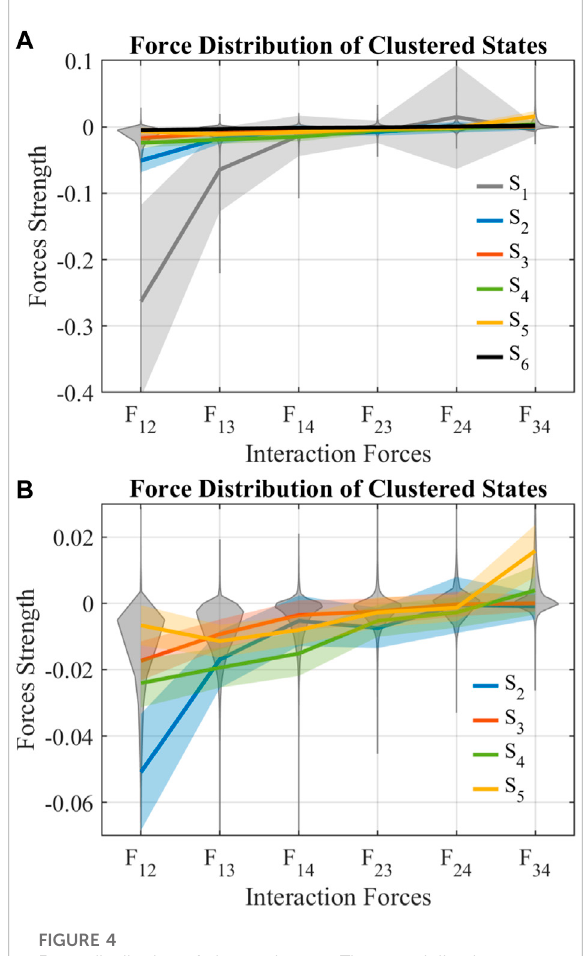
FIGURE 4 Force distribution of clustered states. The gray violin plot shows the distribution of interaction forces. The lines show the mean of interaction forces in respective states, and the shadings around the mean show its standard